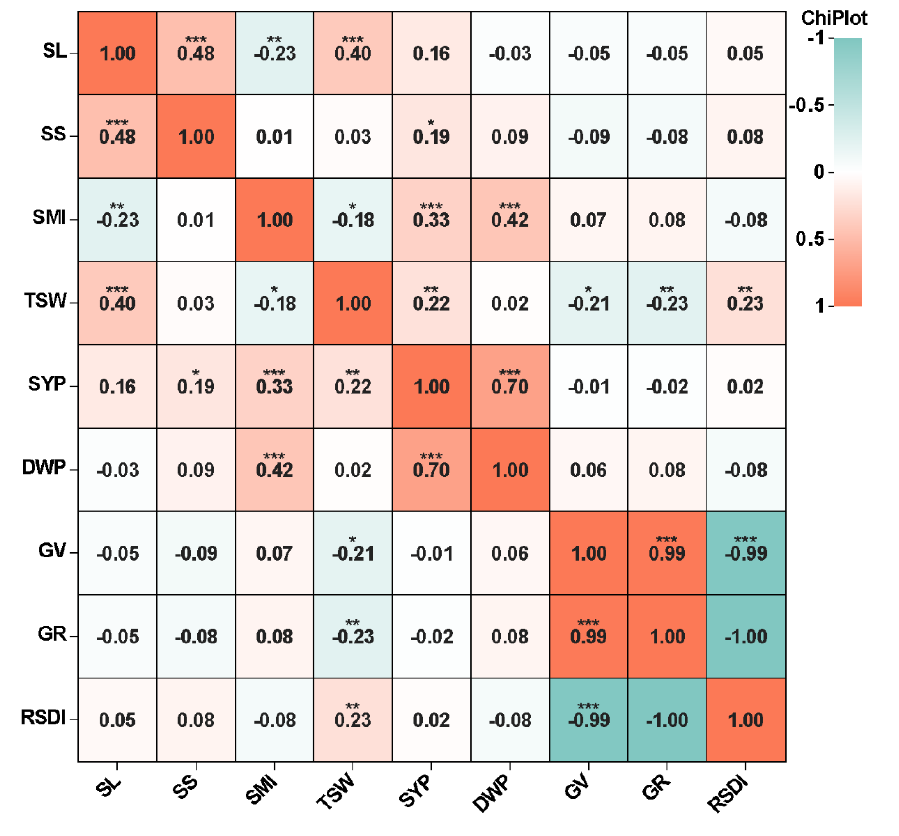
Figure 1. Correlation analysis of all traits for 146 rapeseed accessions. The numbers represent the value of the correlation coefficient. The color of the box indicates the degree of correlation between the row trait and the column trait. The orange box indicates a positive correlation between the two traits; the green box indicates a negative correlation between the two traits. SL, silique length; SMI, siliques on main inflorescence; SS, seeds per silique; TSW, thousand-seed weight; SYP, seed yield per plant; DWP, dry weight per plant; GV, germination vigor; GR, germination rate; RSDI, relative salt damage index. (*), (**), (***) significance levels of 0.05, 0.01 and 0.001, respectively. Table 1. Phenotypic variation of 146 rapeseed